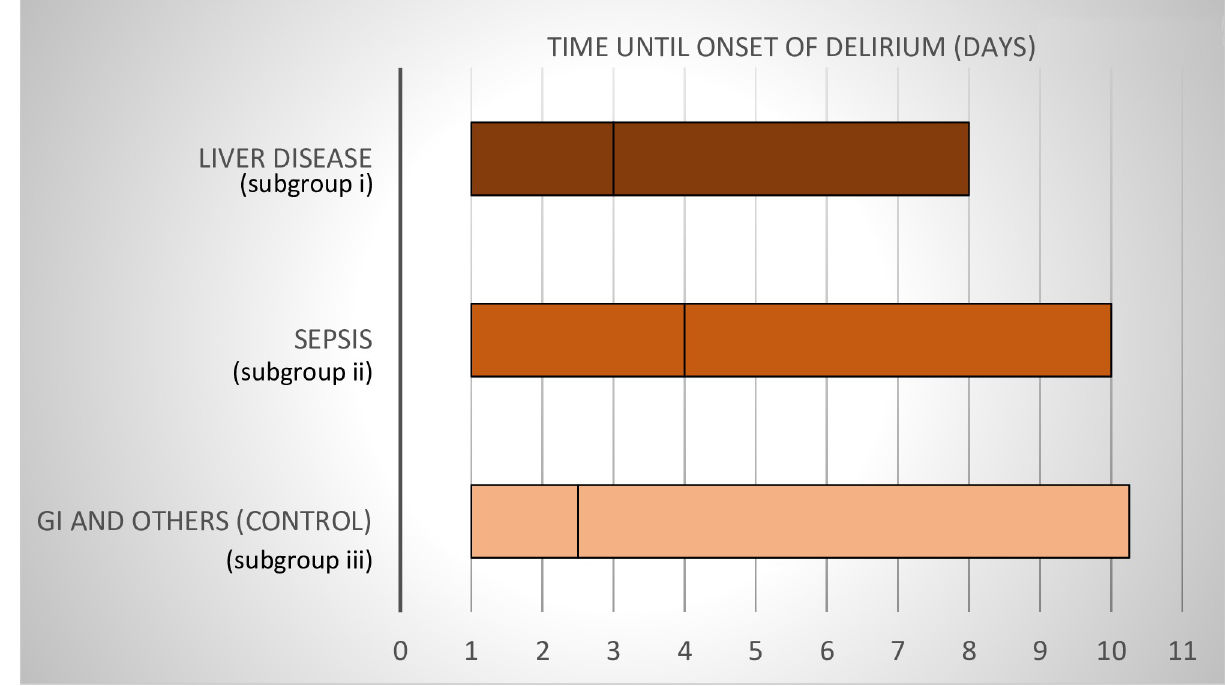
Fig 2. Median time until onset of delirium in the subgroups of patients with liver diseases, sepsis, and GI diseases and others (control). GI =